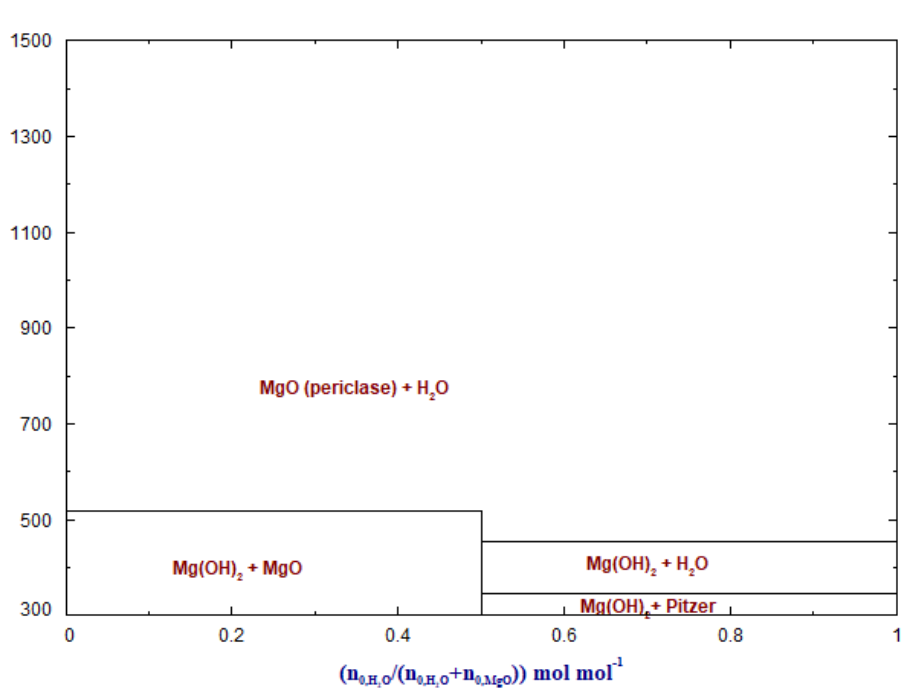
/( n 0,H + n 0,MgO )), /( 𝑛 + 2 O 2 O 0 ,H 2 O 0 ,H 2 O